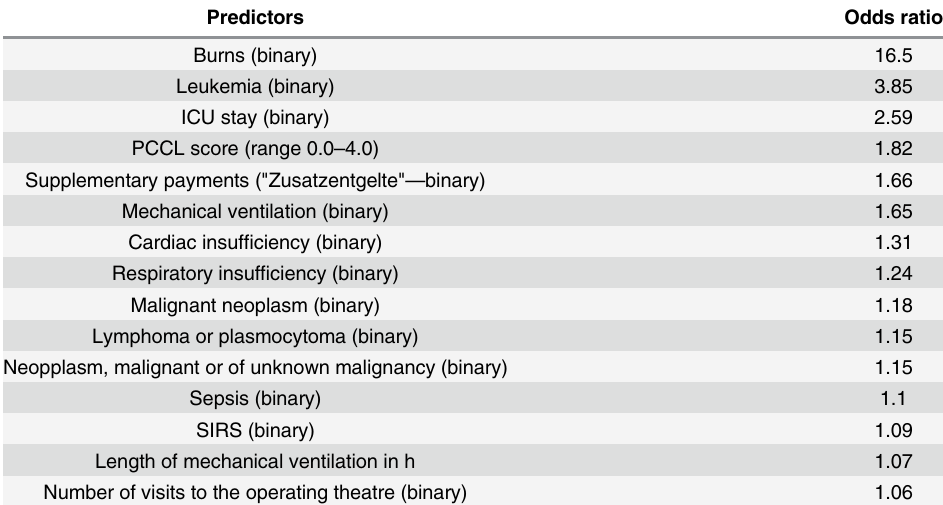
Table 4. 15 most important predictors derived from the L1 regularized logistic regression analysis (LASSO) for profit outliers determined by IQR method. Predictors were ordered by the magnitude of their odds ratio (n = 20,000, training set).